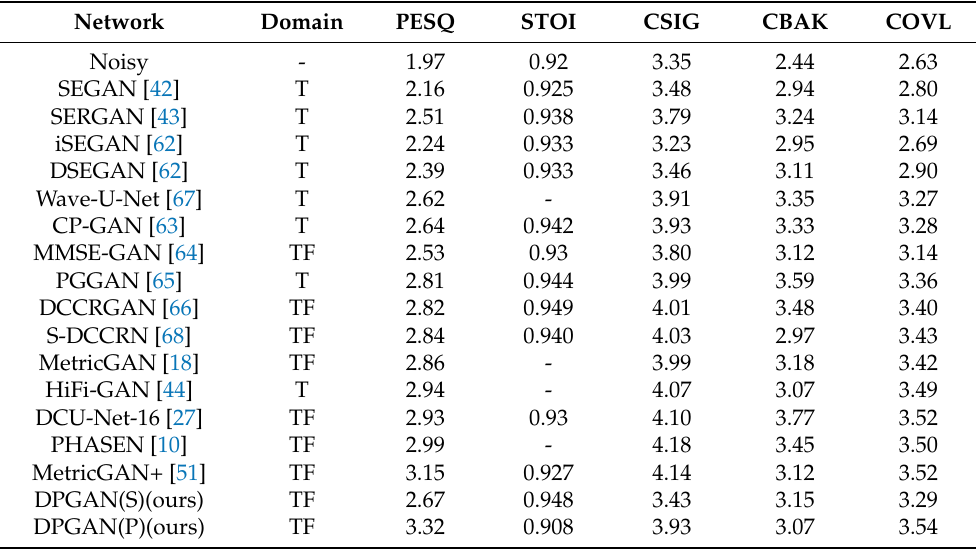
Table 1. Comparison of DPGAN with the other top methods on Voicebank+DEMAND datasets, - indicates that the corresponding results are not given in the text.